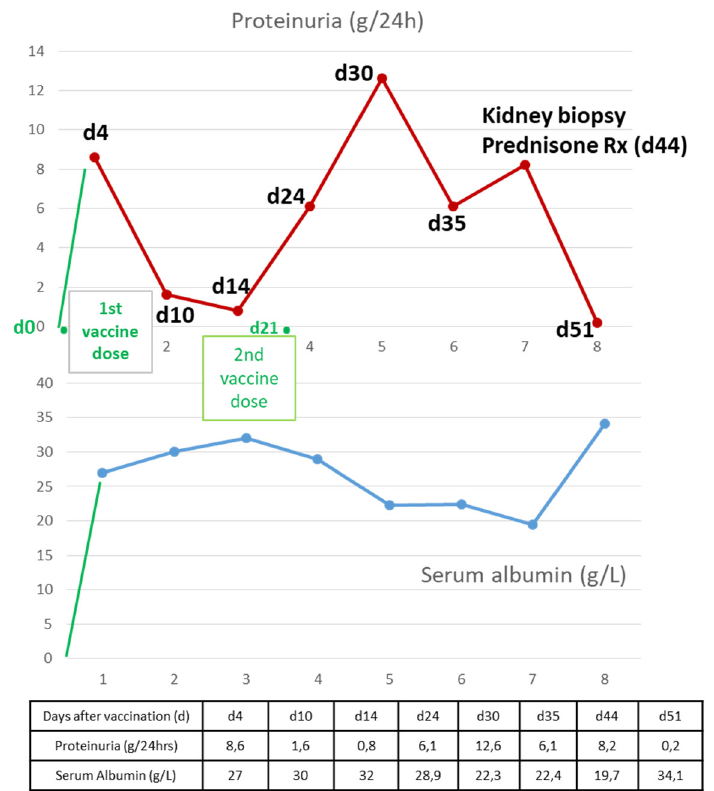
Figure 1. L a boratory data. Figure 1. Laboratory